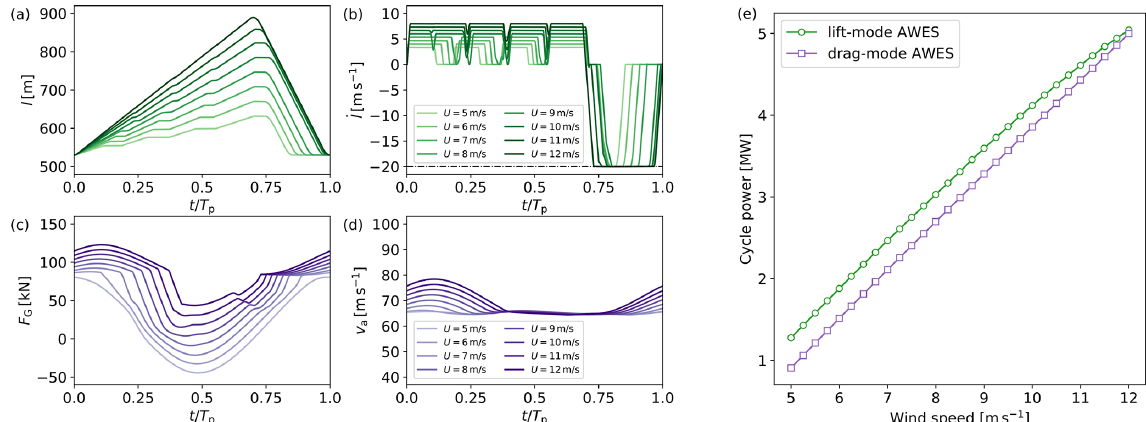
Figure 10. Selected trajectory features (a–d) and power curves (e) of lift- and drag-mode AWE systems in region II. For lift-mode AWE systems, the wind speed dependency of tether length and reel-out speed are shown in (a) and (b) . For drag-mode AWE systems, the wind speed dependency of generator thrust and apparent wind speed magnitude are shown in (c) and (d)